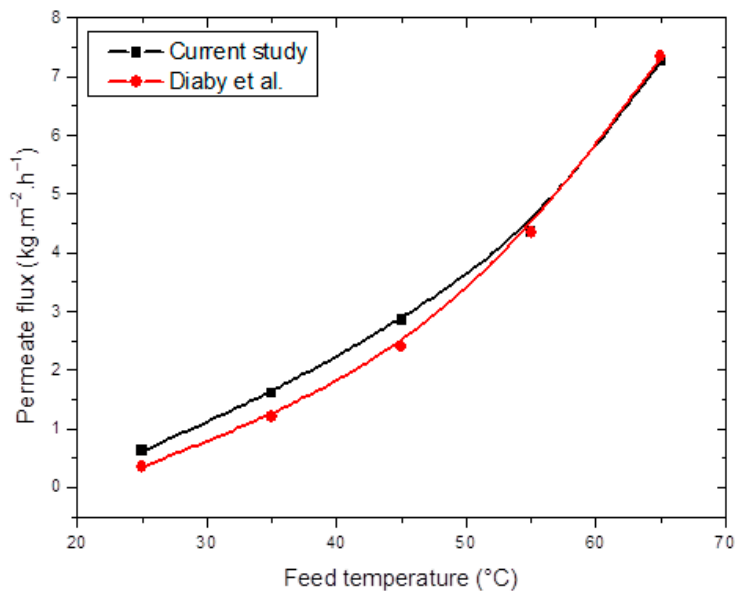
Figure 4. Evolution of permeate flux as a function of feed temperature [38].